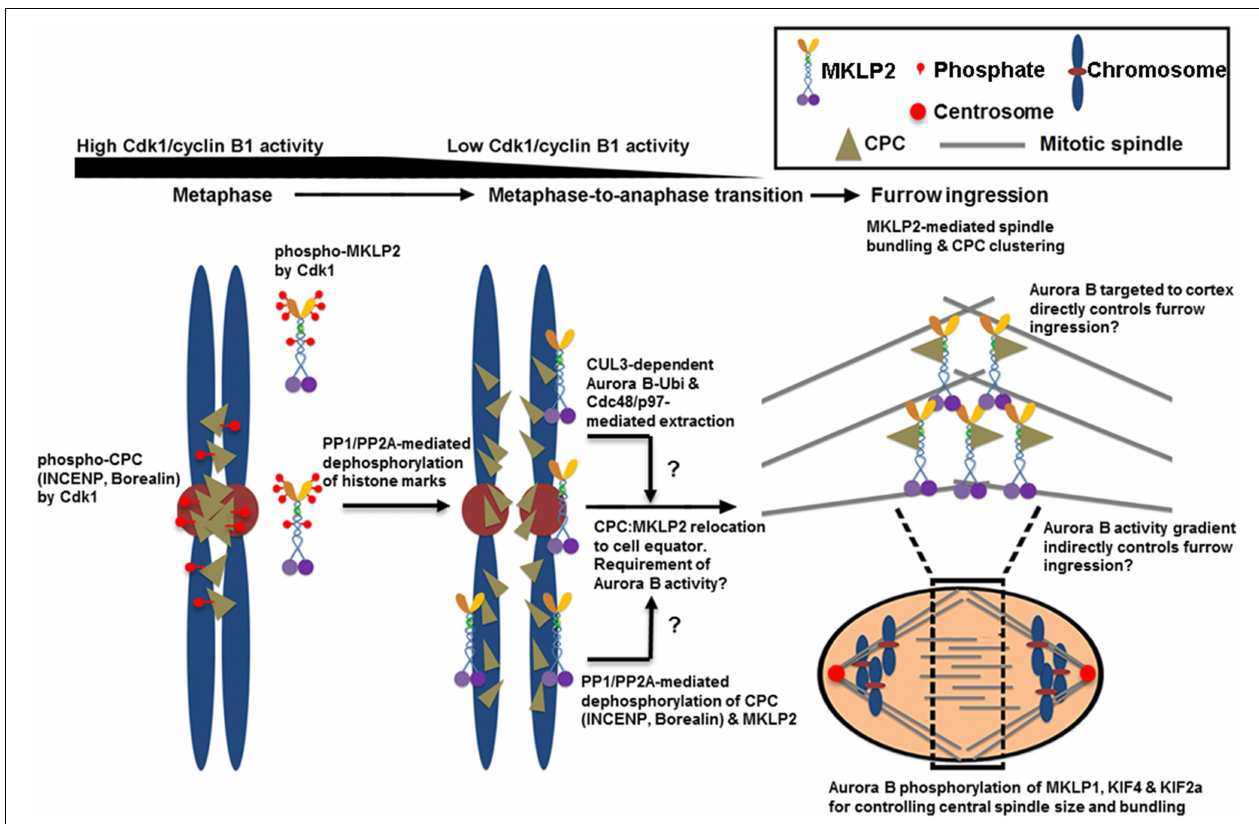
to be removed from anaphase chromosomes via ubiquitination of the Aurora B by CUL3-KLHL9–KLHL13 and CUL3–KLHL21 E3 enzymes. Ubiquitylated Aurora B (and presumably the CPC) is removed from anaphase chromosomes by AAA + ATPase Cdc48/p97 and its adaptor proteins Ufd1–Npl4. This process may contribute to the levels and distribution of the CPC on chromosomes even before anaphase onset, and it may support chromosome decondensation and NER in late anaphase. Whether MKLP2 and Cdc48/p97 collaborate to remove the CPC from anaphase chromosomes is unknown. In the cell equator, the involvement of MKLP2 in microtubule binding, bundling, and oligomerization/clustering may contribute to central spindle assembly/stabilization and clustering/activation of the CPC at the cell equator. This clustering event may also stably deliver the CPC close to the cell cortex for robust furrow ingression directly or indirectly via Aurora B phosphorylation gradients. In the spindle midzone, Aurora B also phosphorylates MKLP1, KIF4, and KIF2a to regulate central spindle size and bundle central